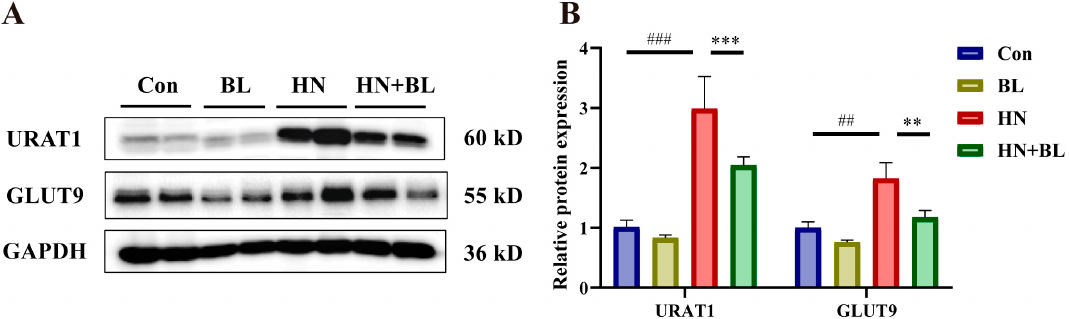
Figure 5. Effects of BL on the relative protein expression levels of renal URAT1 and GLUT9 in mice with HN. (A) The protein bands. (B) Renal URAT1 and GLUT9 protein levels were normalized to GAPDH. Data represent mean ± SD ( n = 4). ## p < 0.01, ### p < 0.001 vs. the Con group; ** p < 0.01, *** p < 0.001, vs. the HN group.